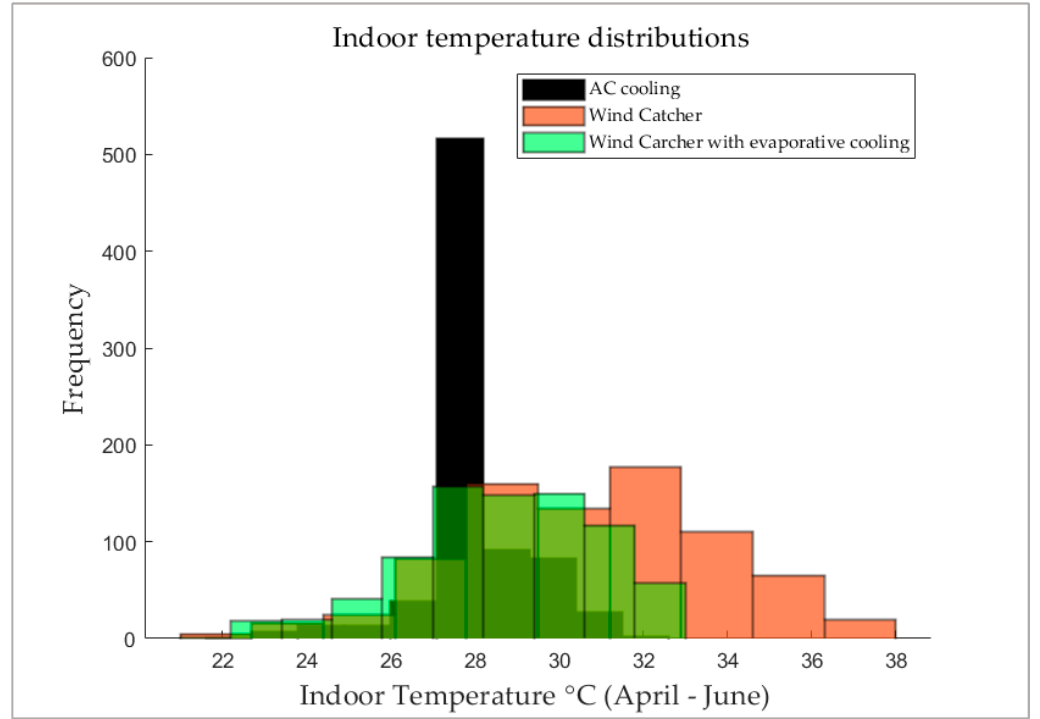
Figure 12. Histograms of indoor air temperature for the three scenarios.